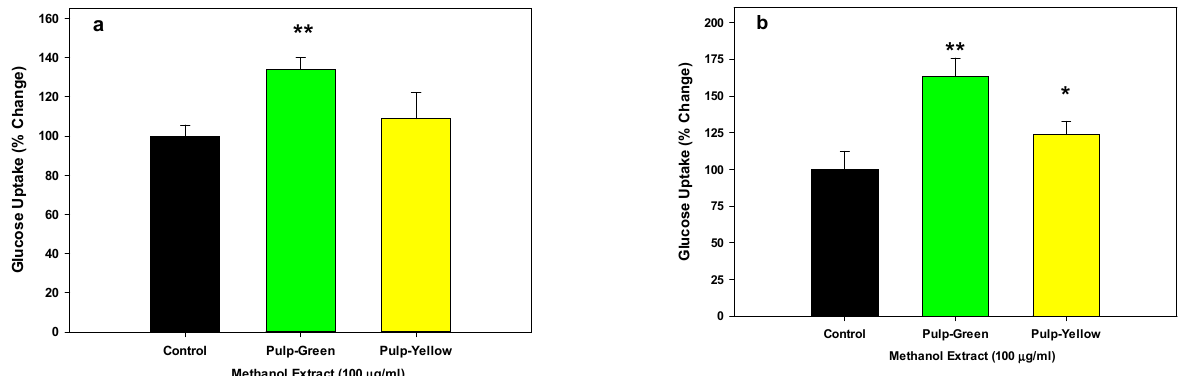
Figure 5. Glucose uptake by green and yellow papaya extract in Hep3B ( a ) and Hu7 ( b ) liver cells: The glucose liver cells were examined using a 2-NBD-glucose, a cell-permeable glucose analog (Cayman Chemical Glucose Uptake Cell-Based Assay Kit) as described in the text. The experiment was conducted in triplicate and data were expressed as % change from vehicle-treated control cells. The statistical analysis was performed using one-way ANOVA (analysis of variance) with Tukey’s HSD post hoc test. The significant difference is represented by “*” at p < 0.05 or “**” at p < 0.01. 3.5. Glucose Transporter, Glut-2 Expression Since methanolic extracts of pulp fraction from green and yellow papaya exhibited a significant increase in glucose uptake, we determined the effect of papaya pulp on Glu-2 expression. The data shown in Figure 6 indicate that the methanol extracts of pulp from both green and yellow papaya similarly stimulated glucose transporter, Glut-2, expres- sion by 75% in liver cells.